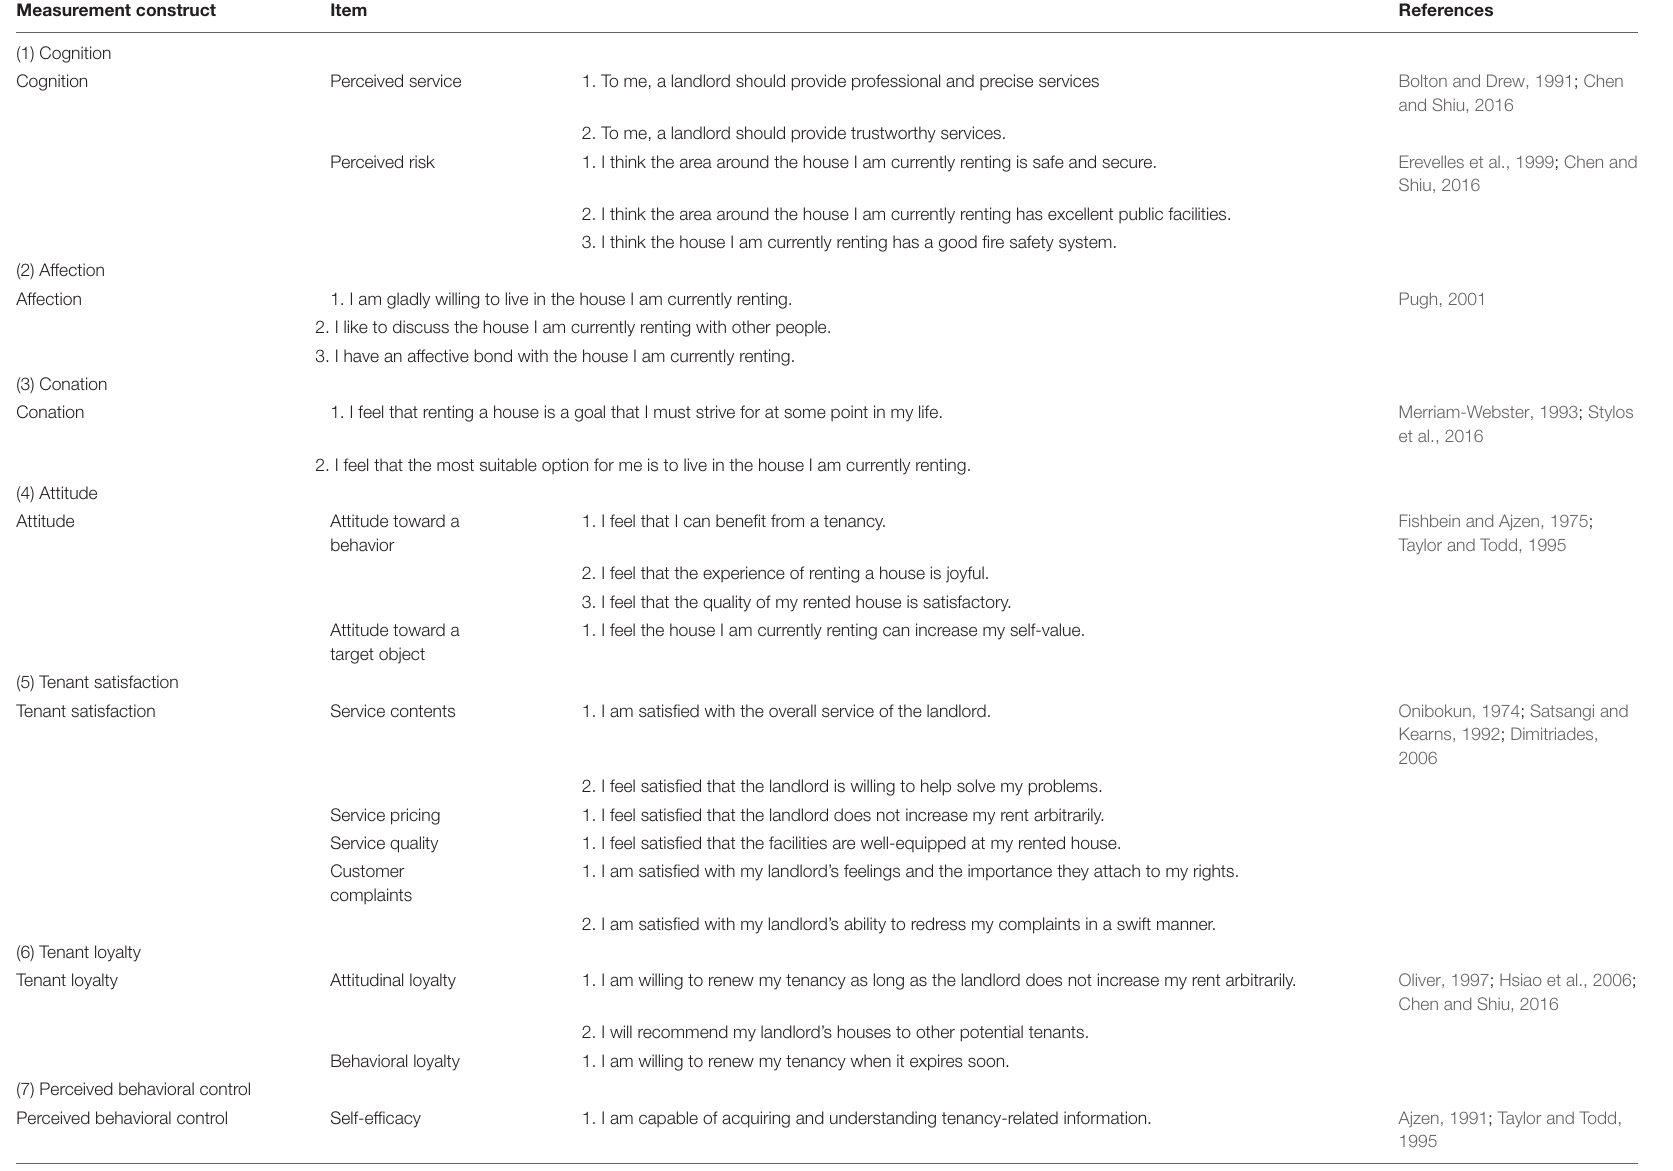
TABLE 1 | Questionnaire items and